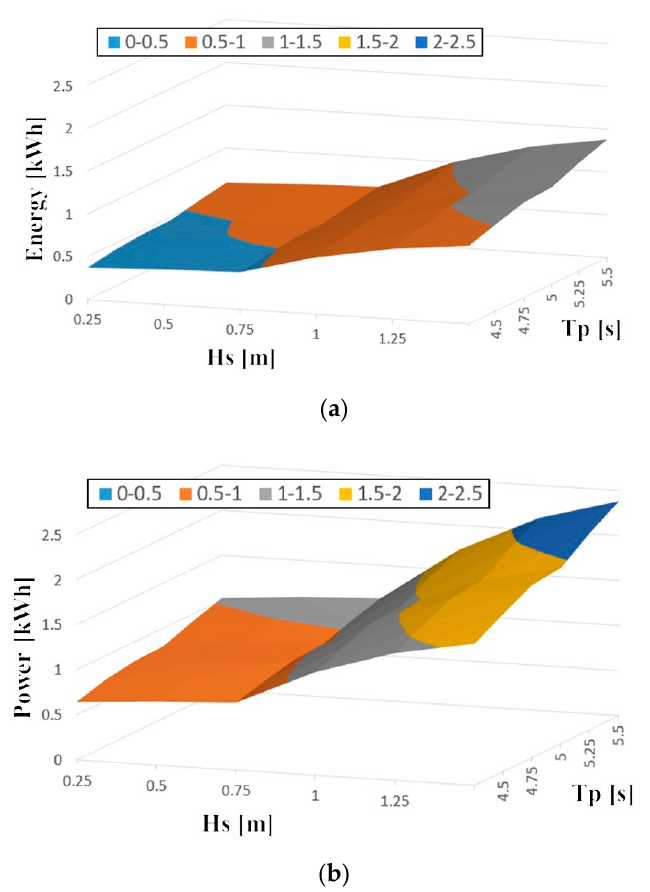
Figure 25. Performance of ( a ) P&O algorithm-based speed control algorithm and ( b ) optimal torque control algorithm according to input condition change.